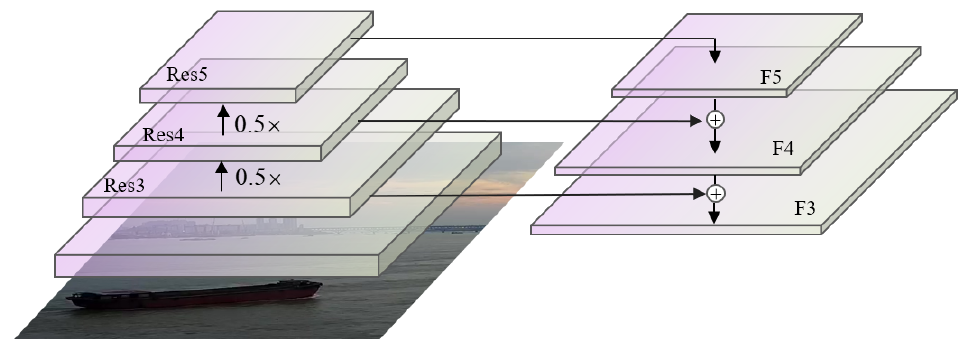
Figure 2. FPN structure in ResNet.